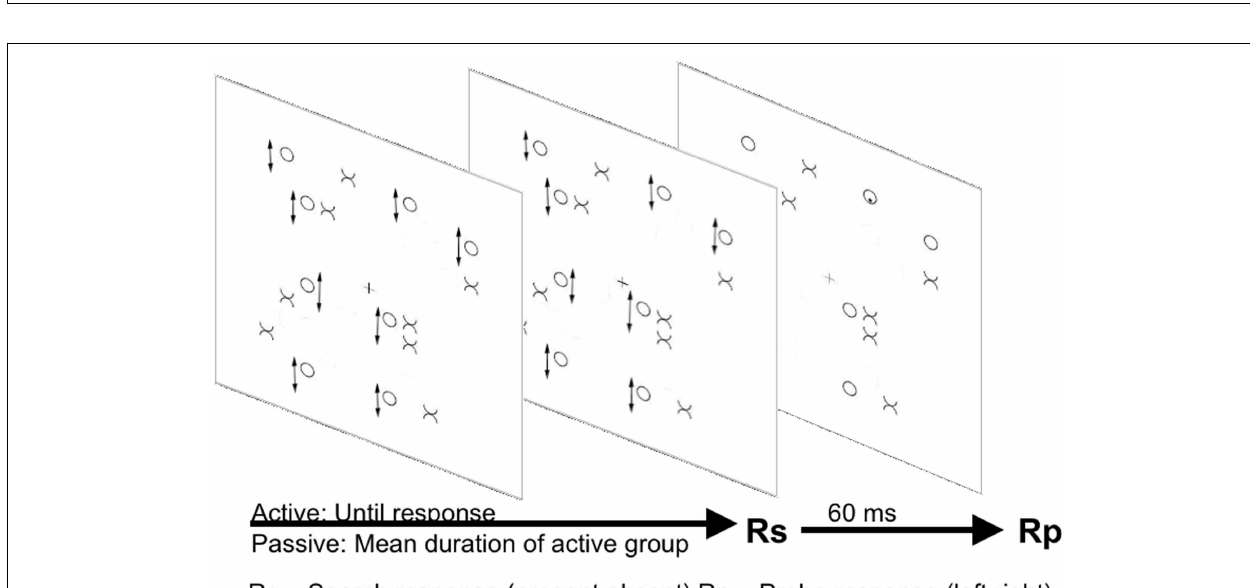
FIGURE 4 | Illustration of the Dent et al. (2012) paradigm. Arrows next to items indicate oscillatory motion. Arrows underneath stimuli panels indicate the passage of time.